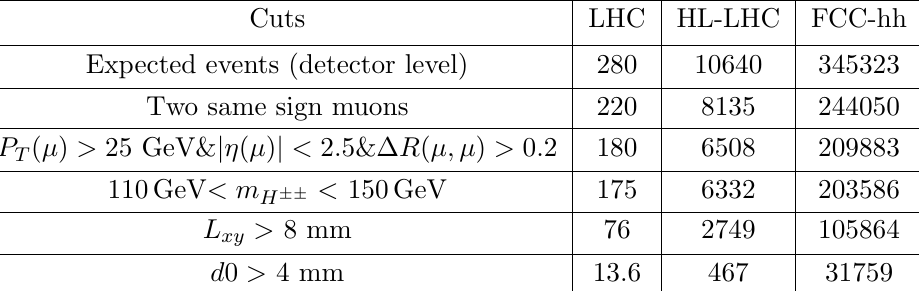
10 (cid:0) 4 GeV and m = 130 GeV was H (cid:6)(cid:6) (cid:2) (cid:13) (cid:3) Z (cid:3) H (cid:6)(cid:6) H (cid:7)(cid:7) only. ! ! integrated luminosity), the (cid:2)